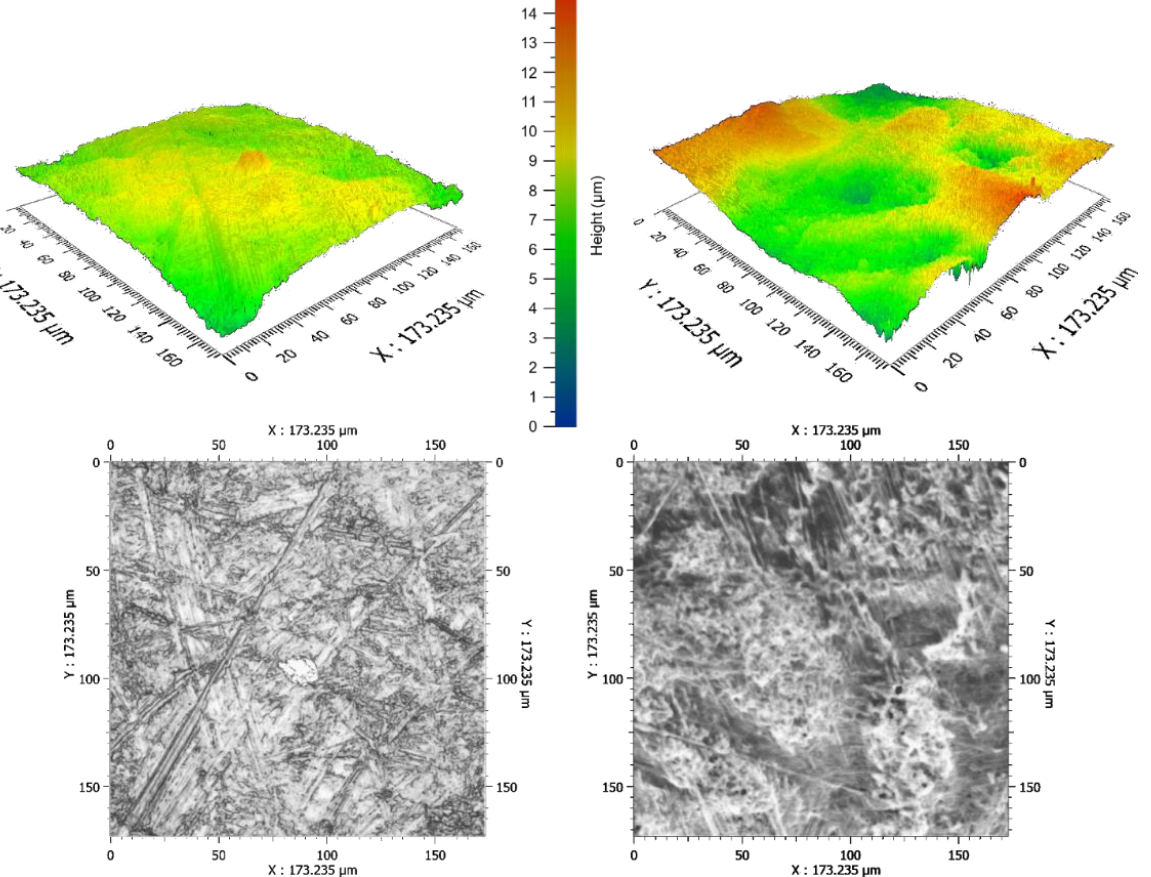
Figure 2. Optical micrographs of the least rough and roughest apple surfaces (( left ): Crown Price Rudolph, ( right ): Elstar) .